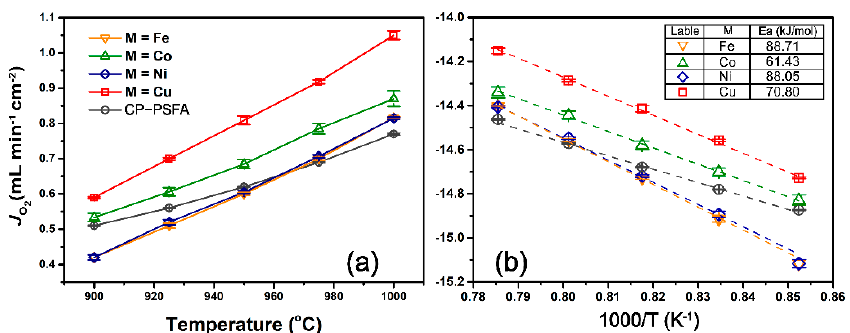
Figure 4. ( a ) Oxygen permeation rates through the CPMPSFA (M = Fe, Co, Ni, Cu) composite membranes. ( b ) Arrhenius plot of oxygen permeation rates for CPM-PSFA (M = Fe, Co, Ni, and Cu) composite membranes. Condition: 150 mL min − 1 air as the feed gas, 49 mL min − 1 He as the sweep gas, 1 mL min − 1 Ne as an internal standard gas. Membrane thickness: 0.6 mm.